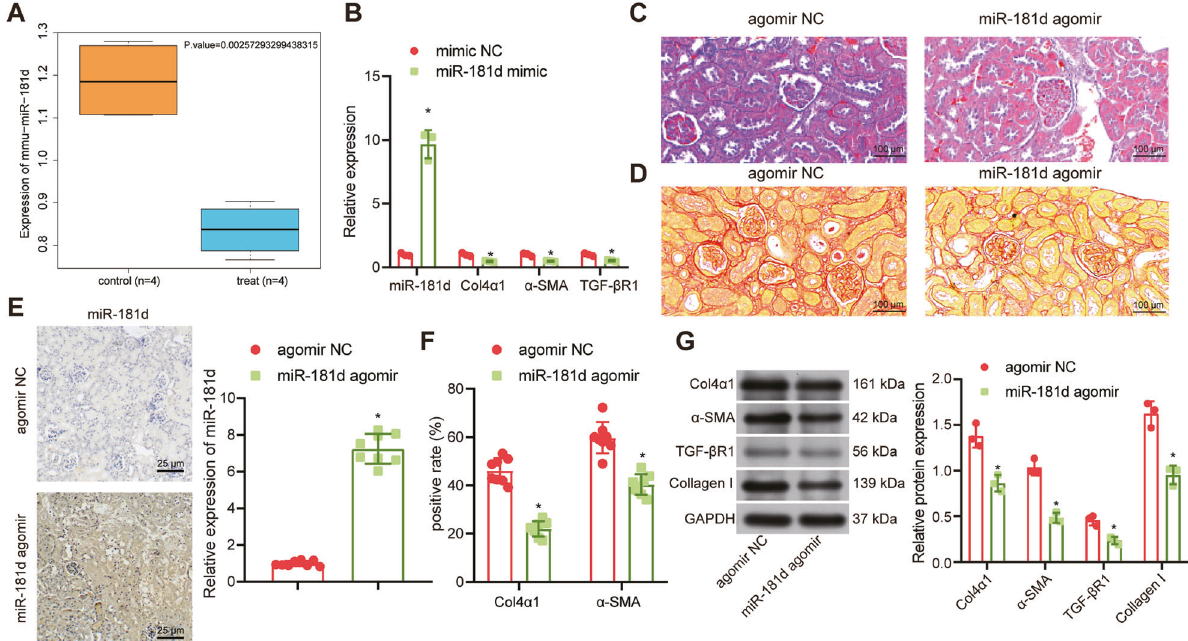
Fig. 3 Overexpression of miR-181d inhibits renal fi brosis in vivo and in vitro. A A box plot of the expression of miR-181d in GSE125305 dataset. The blue box on the left indicates the expression in normal control samples ( n = 9), and the red box on the right indicates the expression in renal fi brosis samples ( n = 9). B RT-qPCR analysis of α -SMA, Col4 α 1, and TGF- β R1 expression in HK-2 cells. C Masson ’ s trichrome staining of collagen deposition in UUO rats after treatment with BMSC-EVs ( n = 8). D Sirius red staining of collagen deposition in renal tissues from UUO rats after treatment with miR-181d agomir ( n = 8). E In situ hybridization to assess miR-181d expression in renal tissues from UUO rats after injection of miR-181d agomir ( n = 8). F Immunohistochemistry assay of Col4 α 1 and α -SMA in renal tissues from UUO rats after injection of miR-181d agomir ( n = 8). G Western blot analysis of Col4 α 1, α -SMA/TGF- β R1 and collagen I expression in renal tissues from UUO rats after injection of miR-181d agomir. * p < 0.05 vs . rats treated with agomir NC. The cell experiment was repeated three independent